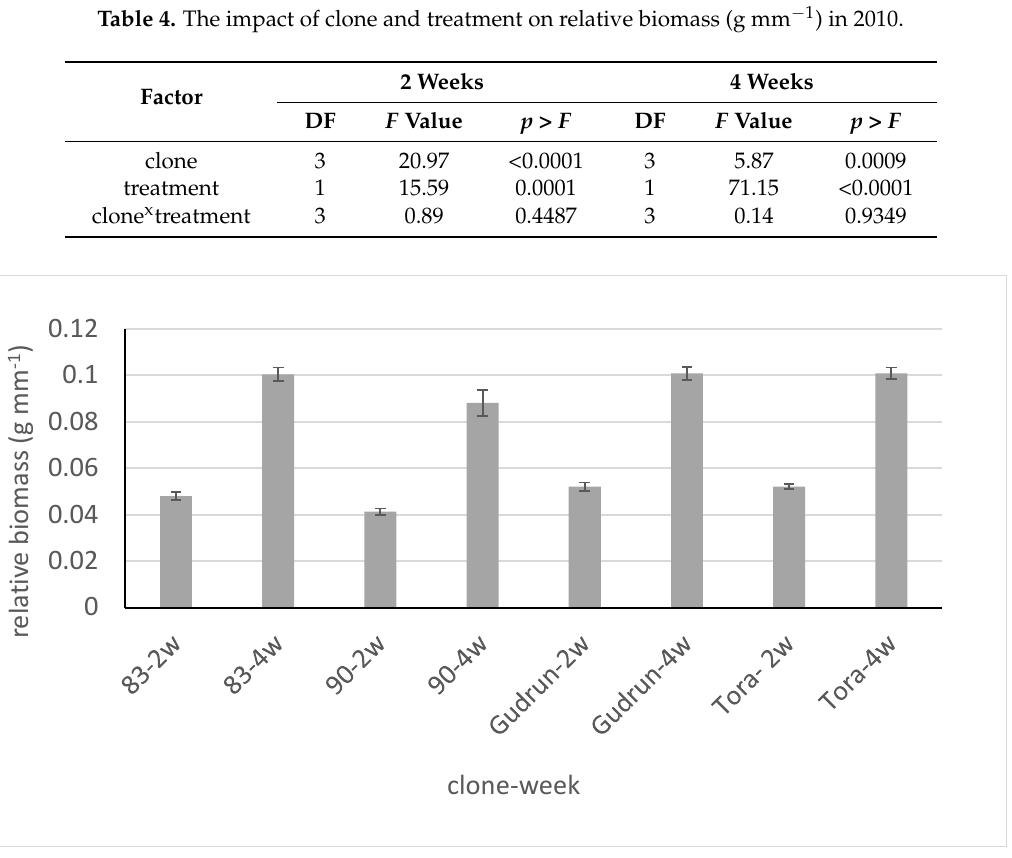
Figure 4. The average relative biomass production by cuttings originating from different clones during two or four weeks in 2010. The bars represent SE ( n = 30). The values of particular harvest time with distinct letters differ from each other significantly (REGW test).